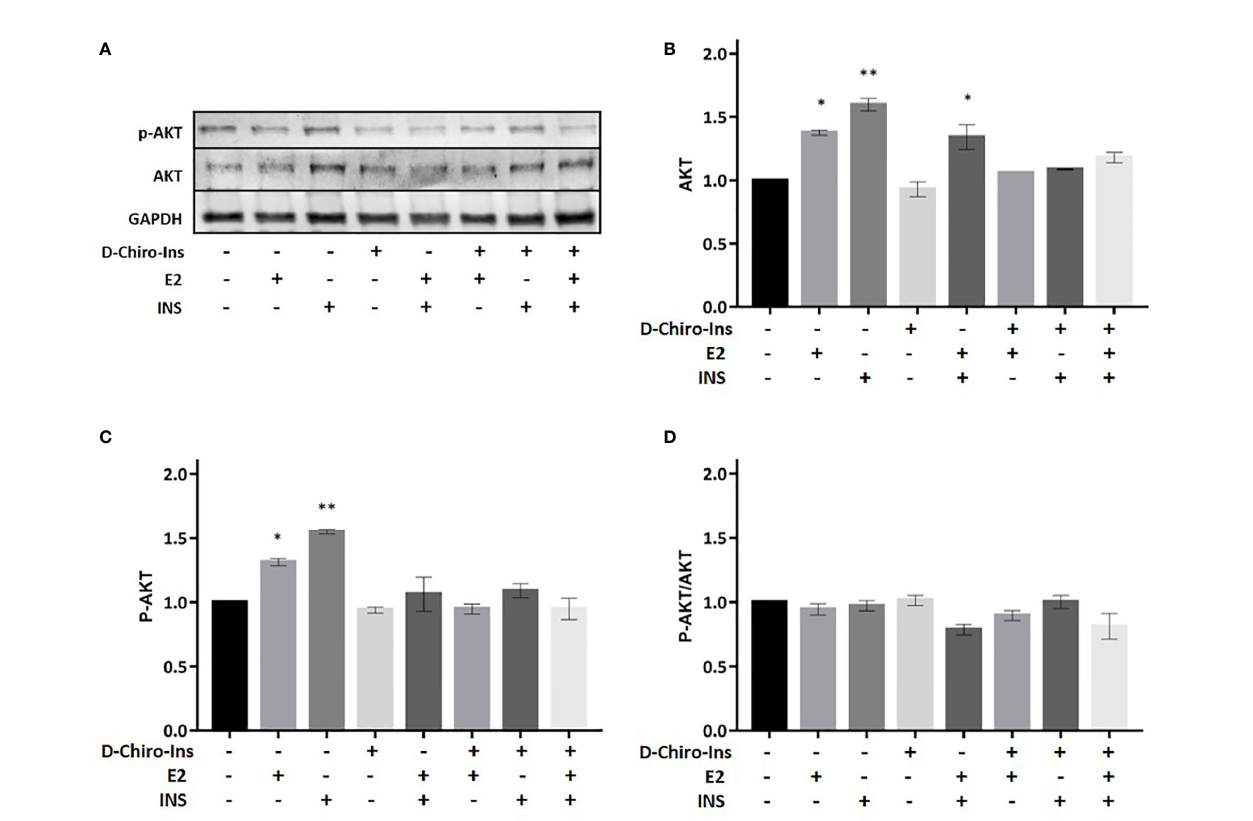
FIGURE 6 | D-Chiro-Ins does not modulate the expression of Akt. Mature SGBS adipocytes cells were treated with D-Chiro-Ins 10 − 8 M, E2 10 − 9 M or INS 10 − 7 M, and combinations for 24 h. Cell lysates were immunoblotted with an anti-Akt antibody, anti-p-Akt antibody, and anti-GAPDH antibody. (A) Panels show representative blot of Akt, p-Akt Ser473 and GAPDH. (B – D) Analysis of the relative expression level of Akt, p-Akt and the ratio p-Akt/Akt. The expression level of Akt and p-Akt was normalized with the protein amount of GAPDH, relative to the control. Values are presented as mean ± SEM of three independent experiments. Results were analyzed statistically by one-way RM ANOVA followed by Dunnett ’ s multiple comparisons test (*p < 0.05, **p < 0.01 versus control). D-Chiro-Ins, D-chiro-Inositol; E2, 17 b -estradiol, INS, insulin; GAPDH, glyceraldehyde-3-phosphate